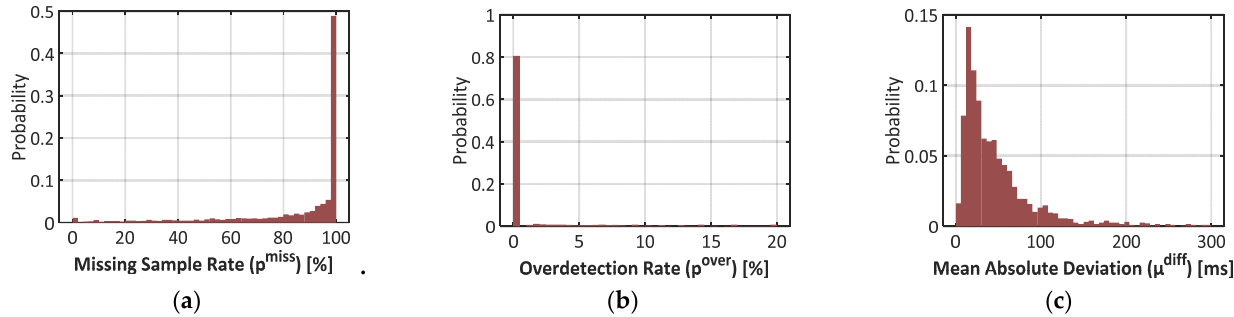
Figure 3. Histograms on three error rates to validate signal IBI e4 with signal IBI bh as the benchmark. ( a ) Proportion of missing samples (p miss ) in signal IBI e4 ; ( b ) Proportion of excess samples (p over )in signal IBI e4 ; ( c ) Mean Absolute Difference (µ diff ) between matching pairs of samples between IBI e4 and IBI bh .